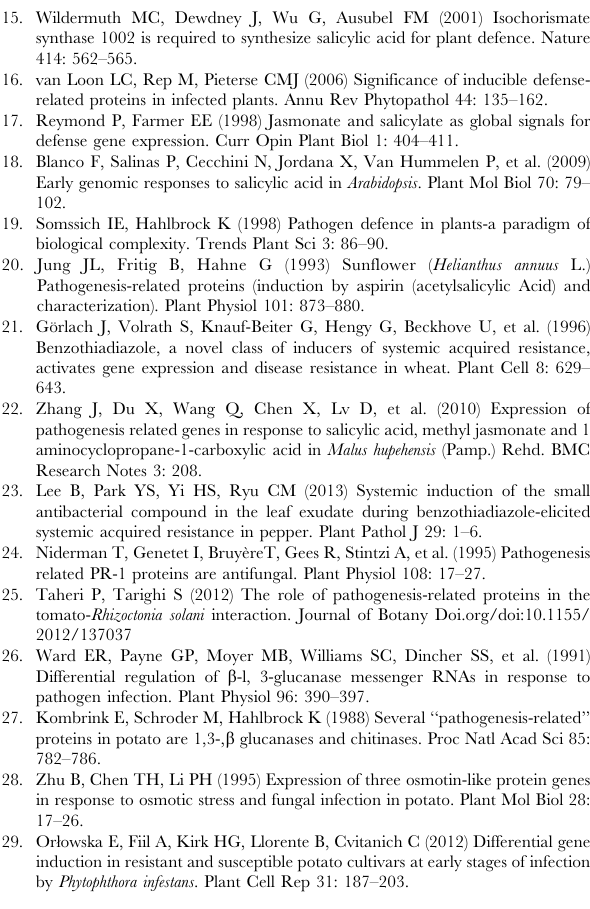
Figure S3 Sequence similarity distribution of transcript contigs from RNA-Seq data of W. somnifera . (TIF) Figure S4 GO mapping of transcript contigs from RNA-Seq data of W. somnifera to different databases. (TIF) Figure S5 Evidence code distribution of transcript contigs (A) and annotated transcript contigs (B) from RNA-Seq data of W. somnifera . (TIF) Figure S6 Annotation score distribution of transcript contigs from RNA-Seq data of W. somnifera . (TIF) Figure S7 GO-level-wise sequence distribution of transcript contigs for (a) Biological processes (b) Molecular functions (c) Cellular components. The initial levels denote the general function of transcript contigs and with progression of levels the function of the transcript contigs becomes more specific. Each transcript contigs can be multi-functional and hence, can lie in more than one ontology domain. Figure S8 Melt curve analysis of reference genes used for normalization of qRT-PCR data.